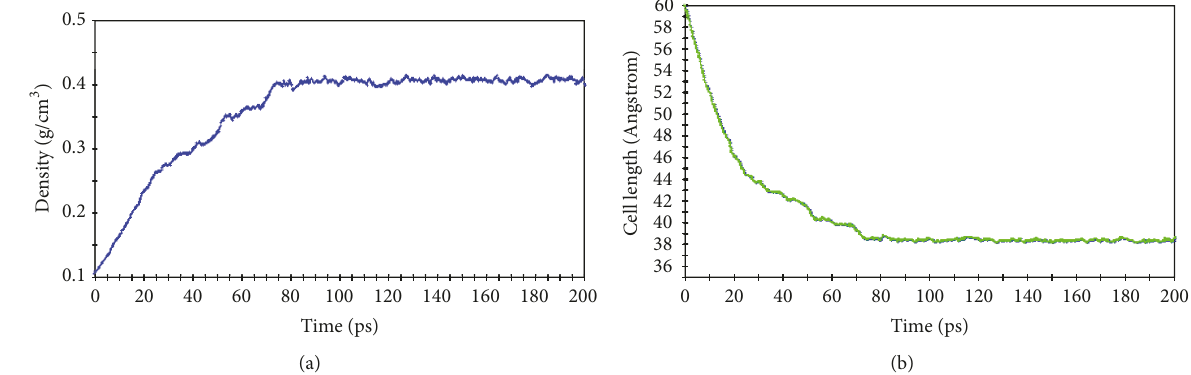
Figure 6: Change of (a) system density and (b) system length of side with time.